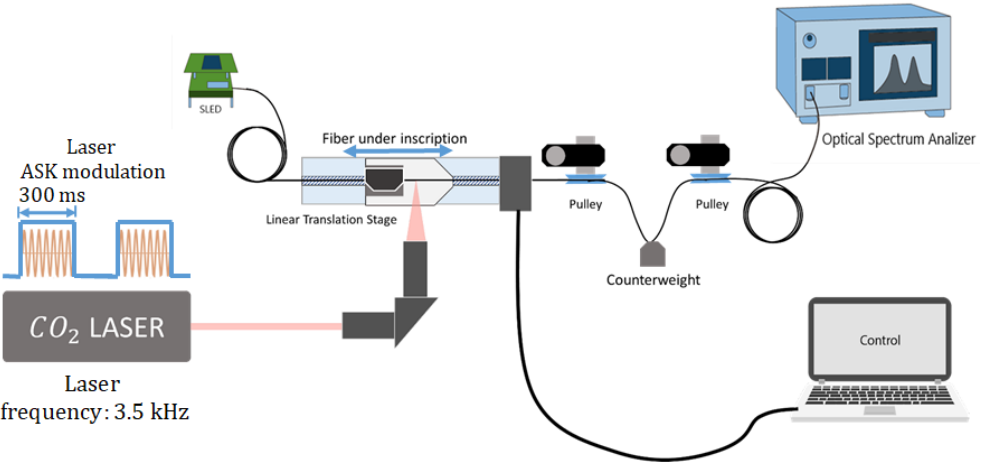
Figure 4. Experimental setup used to fabricate LPFGs using CO 2 laser